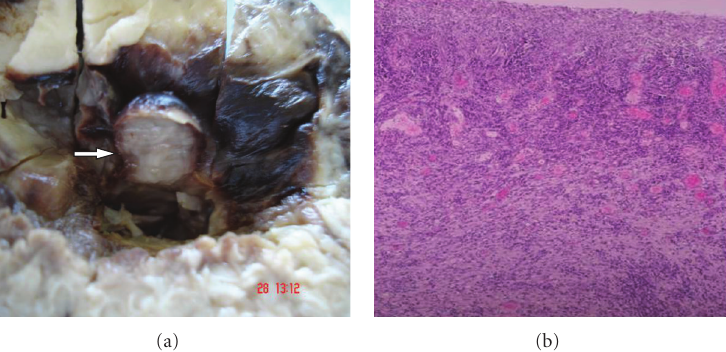
Figure 4: (a) Intraluminal macroscopic view of cystectomy specimen. Recognition of one out of the two polypoid lesions of urinary mucosa (white arrow). (b) Microscopic view of the ulcerated surface of the polypoid lesion (H-E stain X